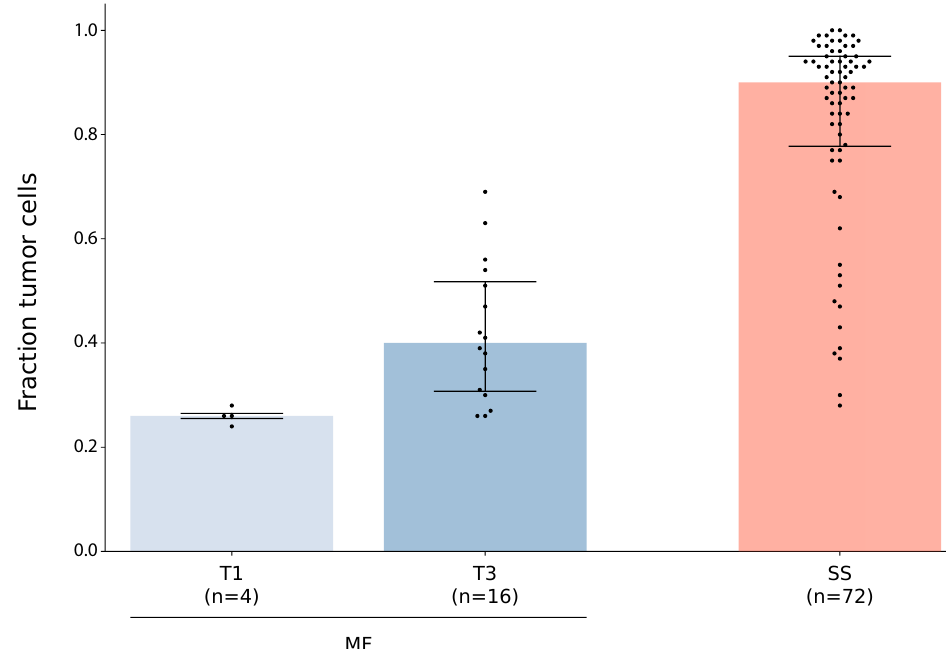
Figure 1. Fraction of tumor cells in samples from different forms and stages of CTCL. WXS or WGS data from this work or from published studies [20,22,23,25] were evaluated for tumor cell fraction using ABSOLUTE [63]. The samples are grouped and classified, according to patient information, into MF with tumor stage 1 or 3, or SS. For each class, sample size, median, and first and third quantile are depicted by horizontal